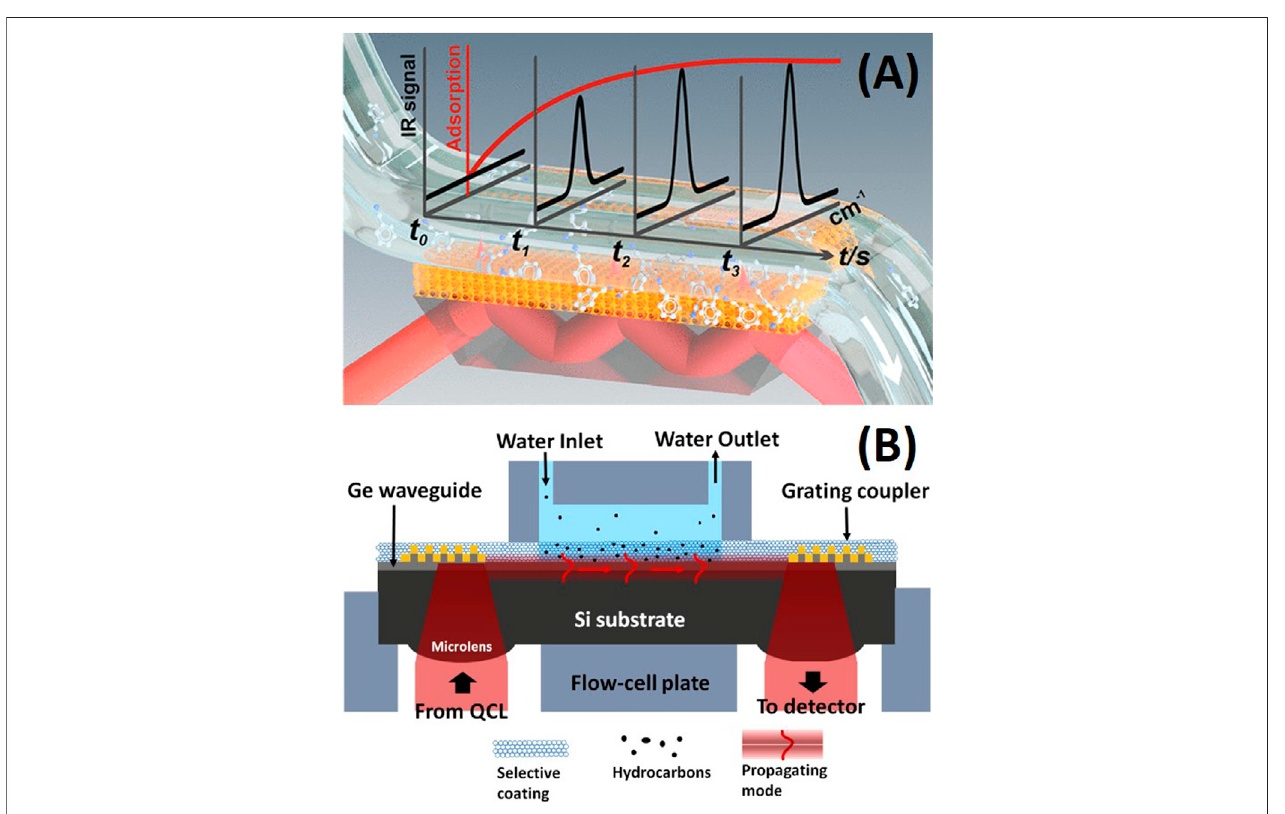
FIGURE 6 | (A) Hybrid porous cladding over ATR crystal for benzonitrile sensing. Reprinted with permission from Baumgartner et al. (2018) Copyright © 2018 American Chemical Society. (B) Schematic illustrating the sensing platforms used by Beneitez et al. Hybrid porous cladding on top a single mode waveguide. Reproduces with the authors permission from Benéitez et al.